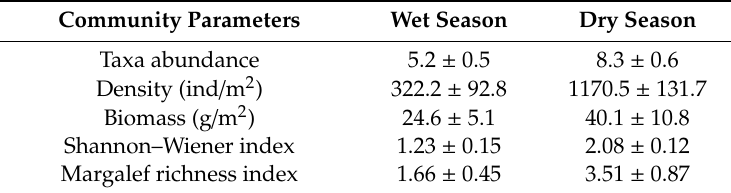
Table 7. Macroinvertebrate community structure parameters (Mean ± SD) in the wet and dry seasons in QYR.